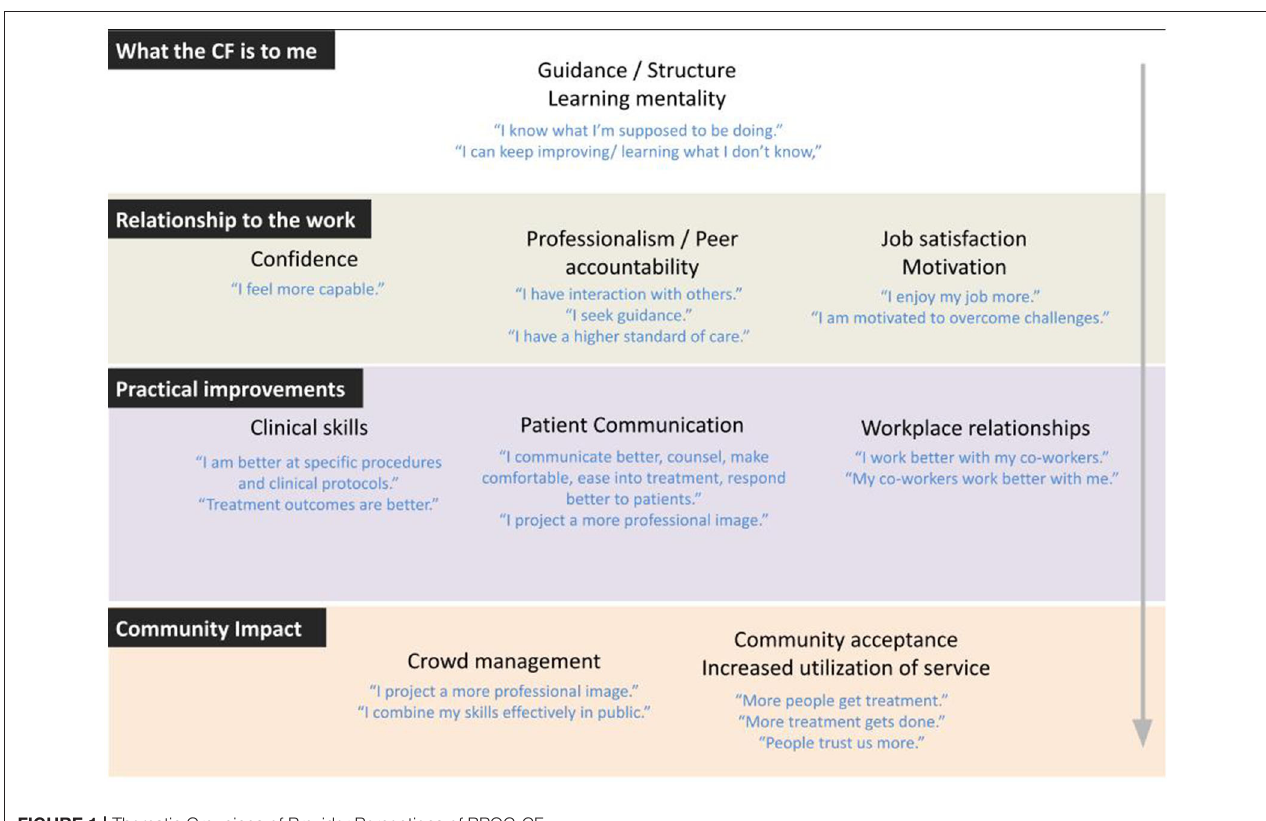
FIGURE 1 | Thematic Groupings of Provider Perceptions of BPOC-CF.